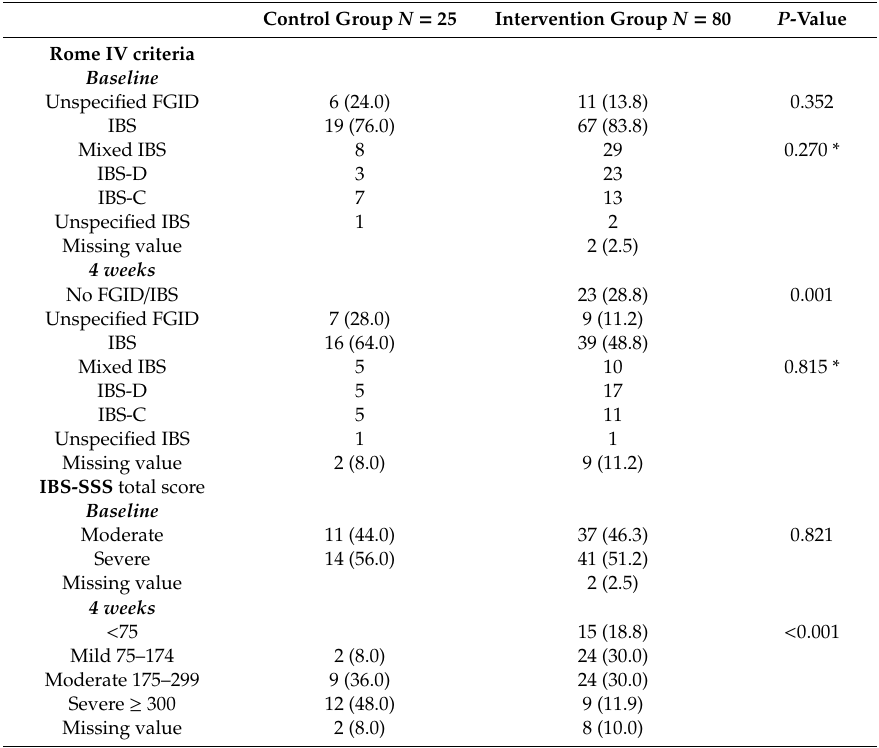
Table 2. Gastrointestinal symptoms in the cohort.